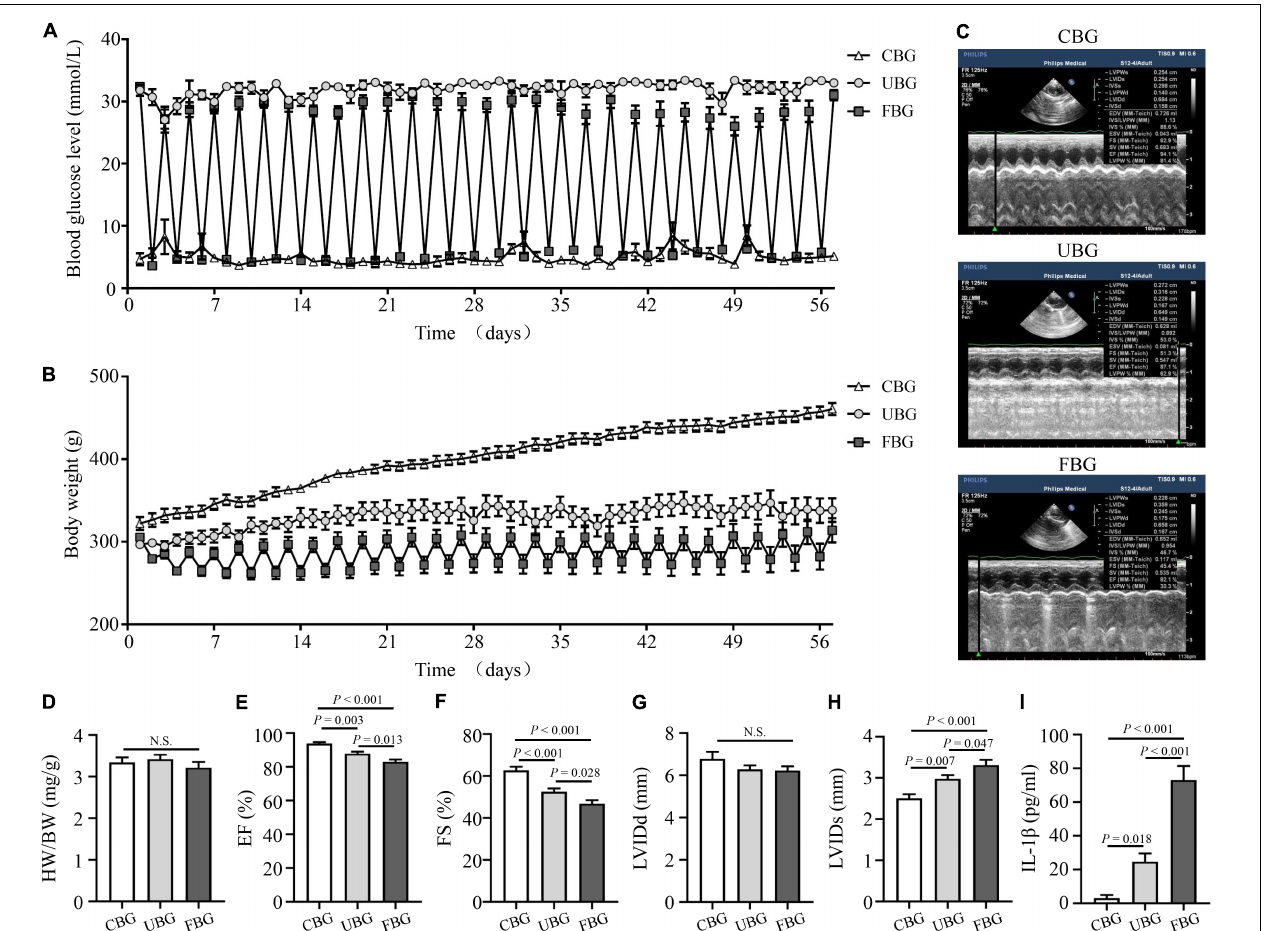
FIGURE 1 | Glucose fluctuations promoted rat left ventricular systolic dysfunction. (A) Levels of blood glucose in the CBG, UBG, and FBG groups ( n = 8 per group). (B) Body weight in the three groups ( n = 8 per group). (C,D) Representative echocardiographic images of rats and heart weight/body weight (HW/BW) in the three groups ( n = 8 per group). (E–H) Representative echocardiographic images of rats, left ventricular ejection fraction (% EF), left ventricular fractional shortening (% FS), left ventricular internal diameter at end-diastole (LVIDd), and left ventricular internal diameter at end-systole (LVIDs) examined by echocardiography ( n = 8 per group). (I) IL-1 β level in the three groups ( n = 6 per group). N.S.: No